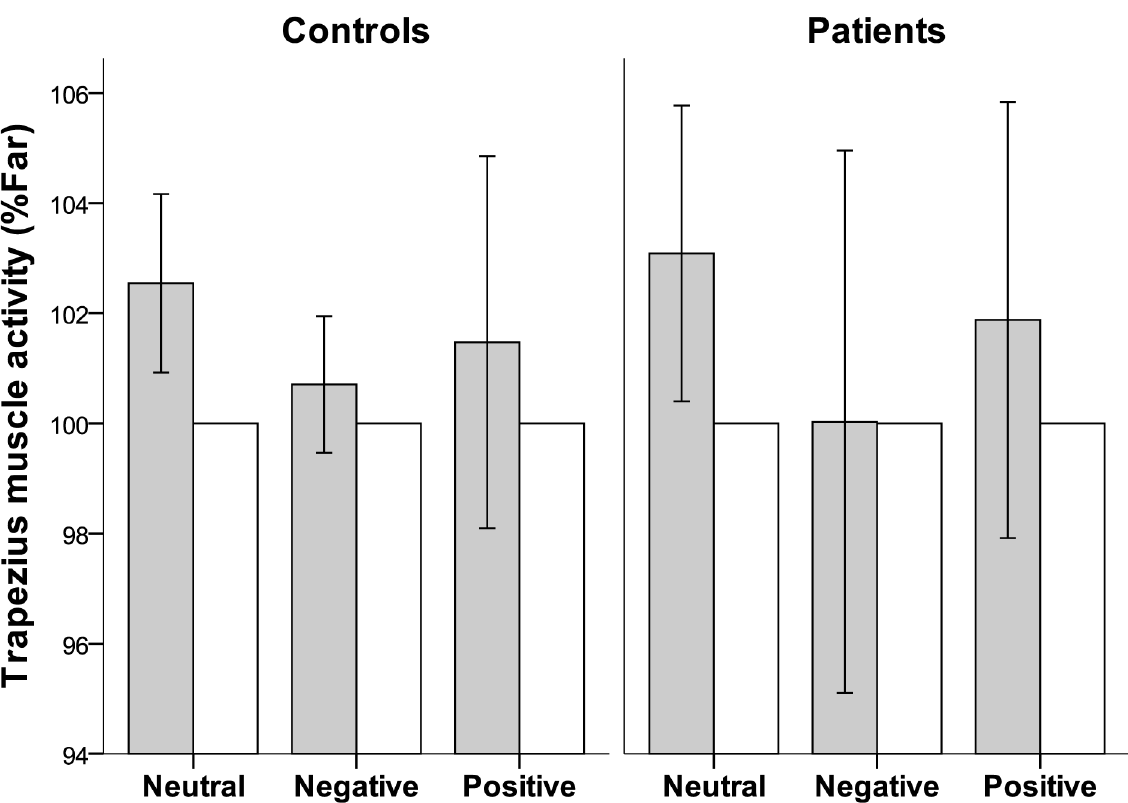
Fig 5. Trapezius muscle activity. Mean trapezius muscle activity (in %Far, with 95% confidence intervals) for the control group (n = 14) and for the patient group (n = 12) for the three viewing conditions. The grey bars shows muscle activity during near focusing and the white bars muscle activity during far focusing. The RMS EMG value from the Near periods for a specific viewing condition, was normalised to the mean RMS EMG value from the Far periods for the same viewing condition and expressed in %Far. In this way the value of the Far period was set to 100%Far for each trial lens. The white bars represents